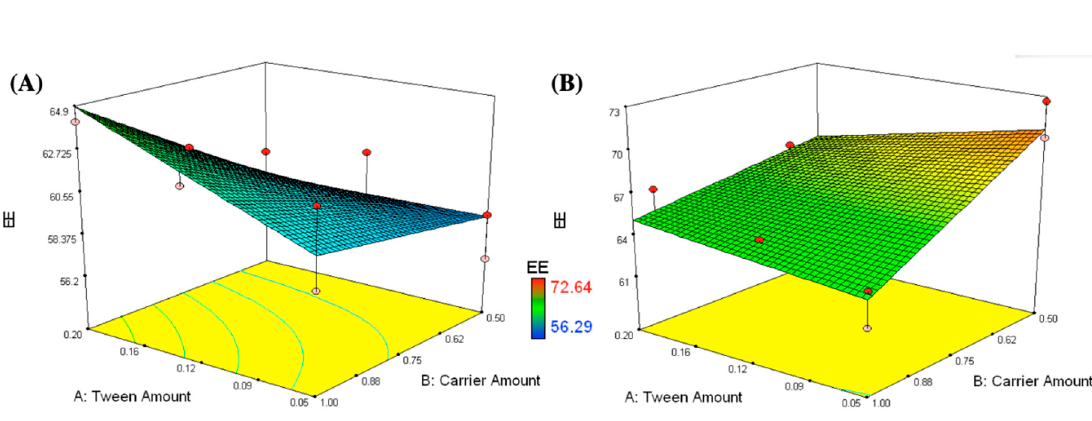
e ffi ciency of the formulations loaded on di ff erent types of carriers (X 3 ); mannitol ( A ) and Aerosil ( B